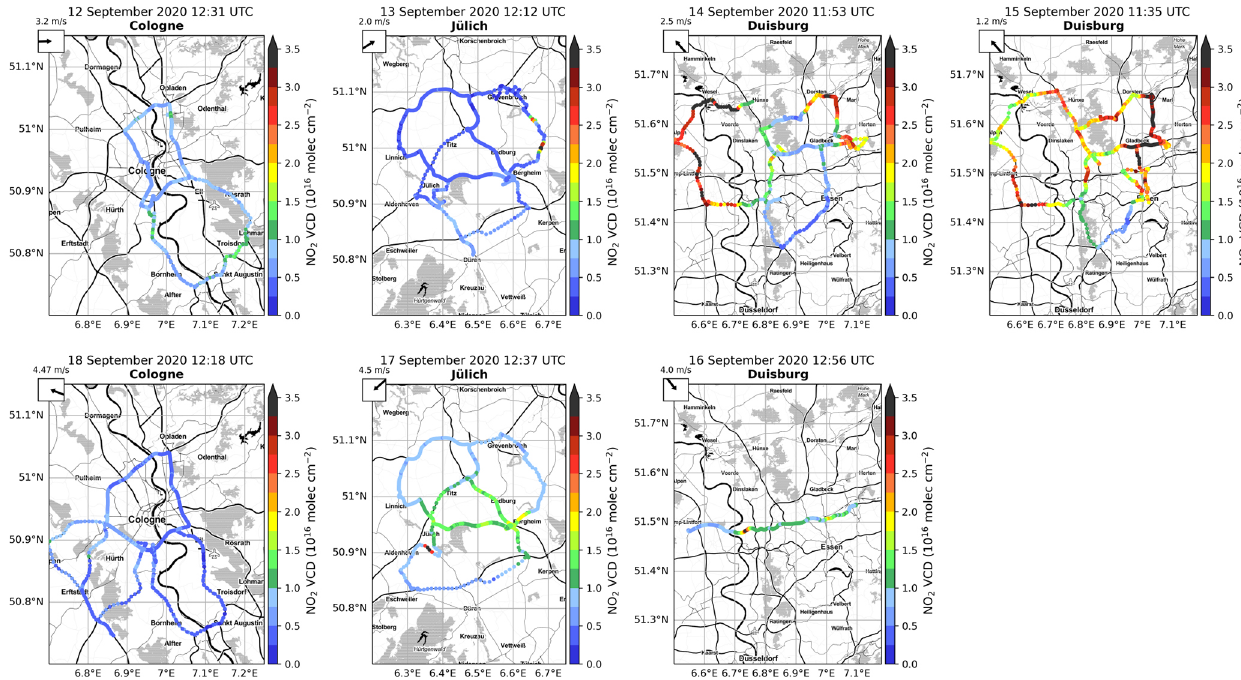
Figure 5. Maps of tropospheric NO 2 VCDs from car DOAS measurements from 12 to 18 September 2020 in the research flight areas around Cologne, Jülich, and Duisburg. Measurements are within ± 1h of the S5P overpass time given in the